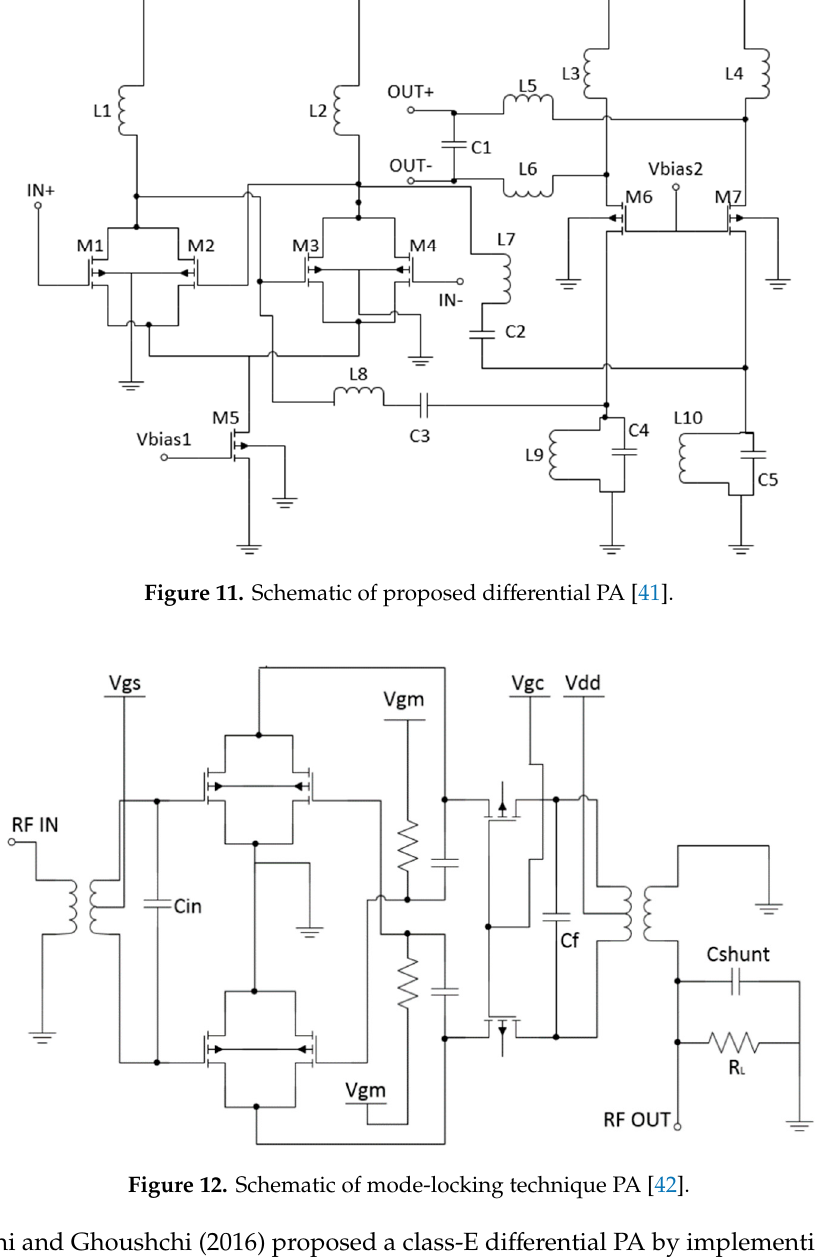
Figure 12. Schematic of mode-locking technique PA [42].